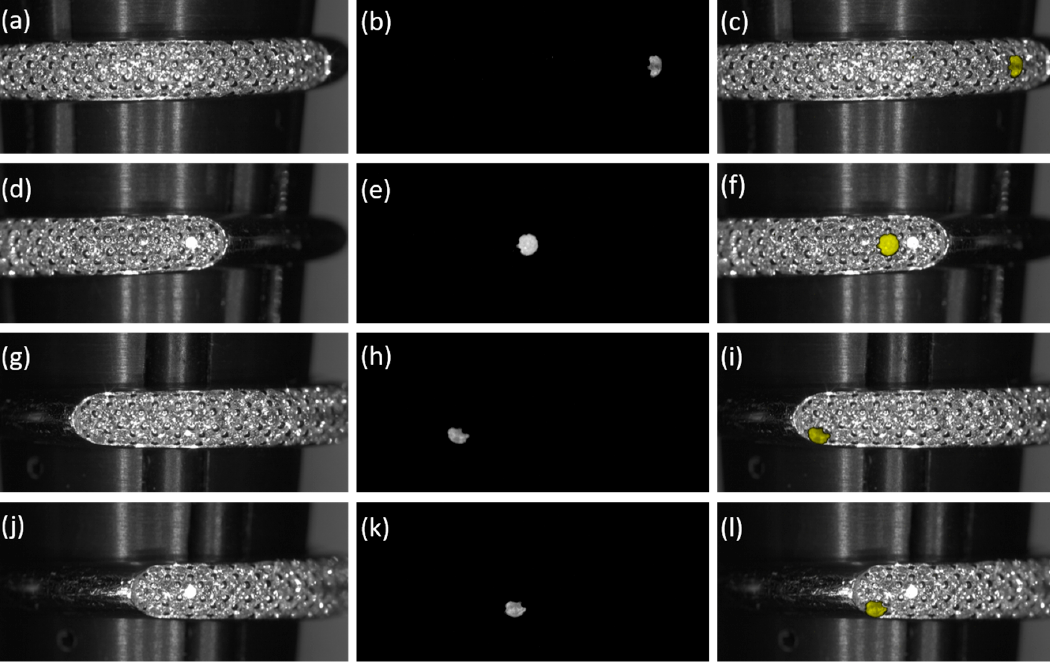
Figure 5. Images of diamond ring jewellery containing two CZ synthetic stones hidden in diamond encrusted band. Left to right: the jewellery piece was in a static position and images acquired in white-light at F#4 ( a,d,g,j ), near-infrared luminescence with green LED excitation at F#1.4 ( b,e,h,k ) and resulting yellow false colour overlay ( c,f,i,l ). Rows beginning (a) and (d) first CZ stone imaged at two viewpoints as band rotated. Rows beginning (g) and (j) second CZ stone imaged at two viewpoints as band rotated.